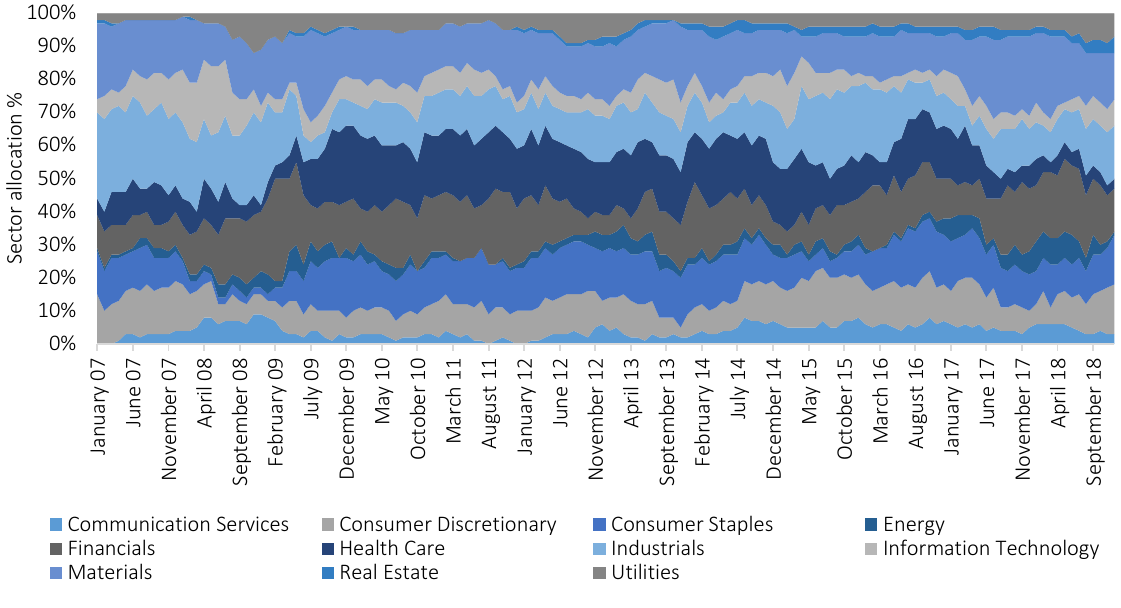
Figure 1d. Scaled volatility sorted low-risk portfolio sector profile